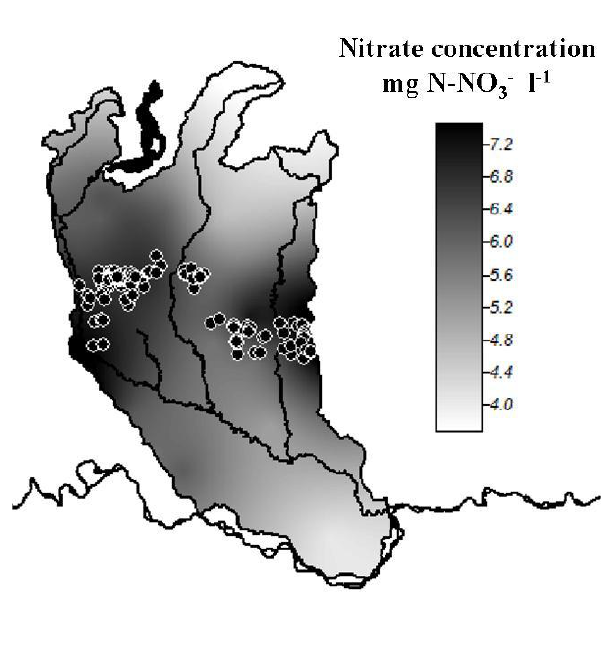
Fig. 7. Mean nitrate concentrations in the surficial aquifer within the Oglio River basin (mgN-NO − l − 1 , data from 2002–2008). Black 3 dots show the location of censused springs within the watershed and highlight the location of the springs belt, which is at the interface between high and middle